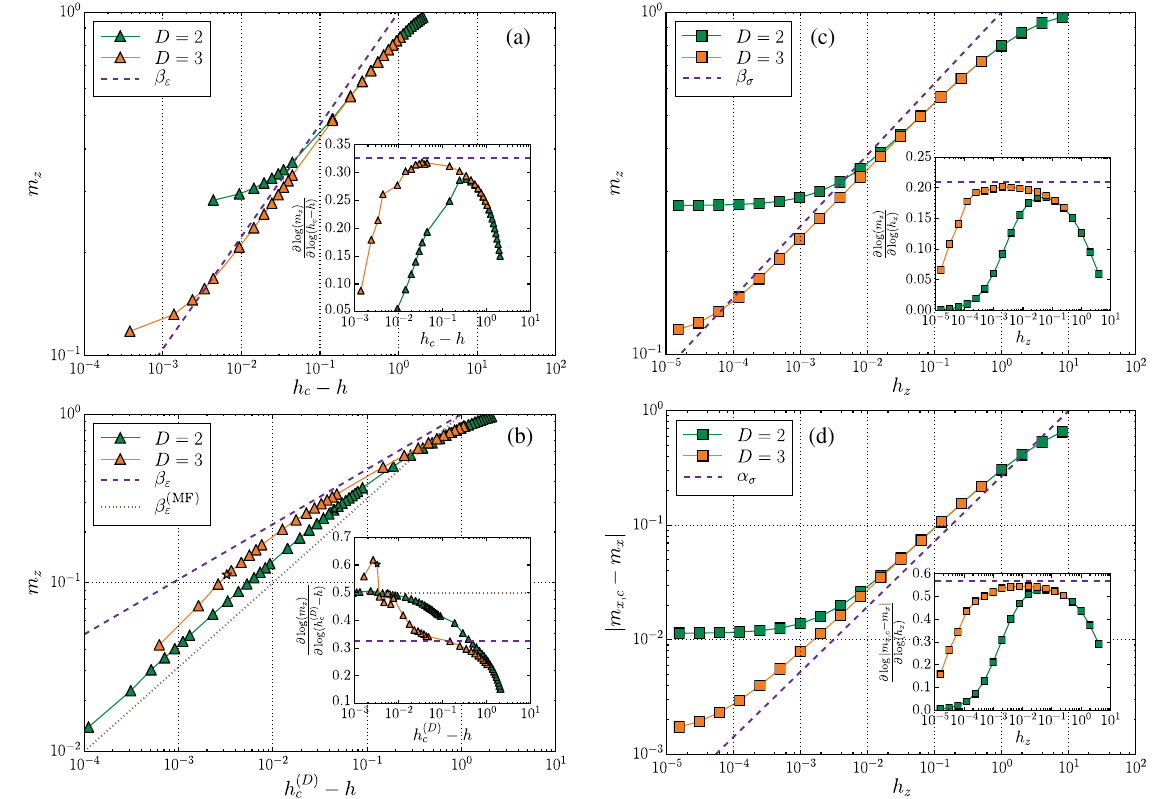
FIG. 3. Analysis of the critical behavior of the m z and m x magnetizations in the vicinity of the critical point at h ¼ h c , h z ¼ 0 . (a) m z as a function of h c − h ; inset shows good convergence to the expected β ϵ exponent. (b) m z as a function of h to mean-field behavior. (c) m z as a function of h z ; inset shows good convergence to the expected β σ exponent. (d) j m x − m x;c j as a function of h z ; inset shows good convergence to the expected α σ exponent. The expected exponents are shown in Table